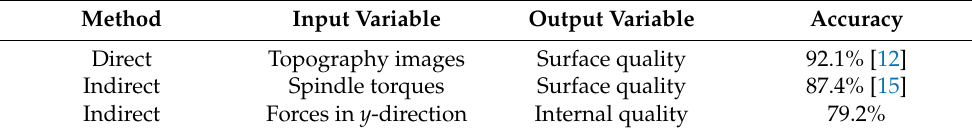
Table 2. Achieved accuracies for process monitoring in friction stir welding (FSW) via CNNs. Method Input Variable Output Variable Accuracy Direct Topography images Surface quality 92.1% [12] Indirect Spindle torques Surface quality 87.4% [15] Indirect Forces in y -direction Internal quality